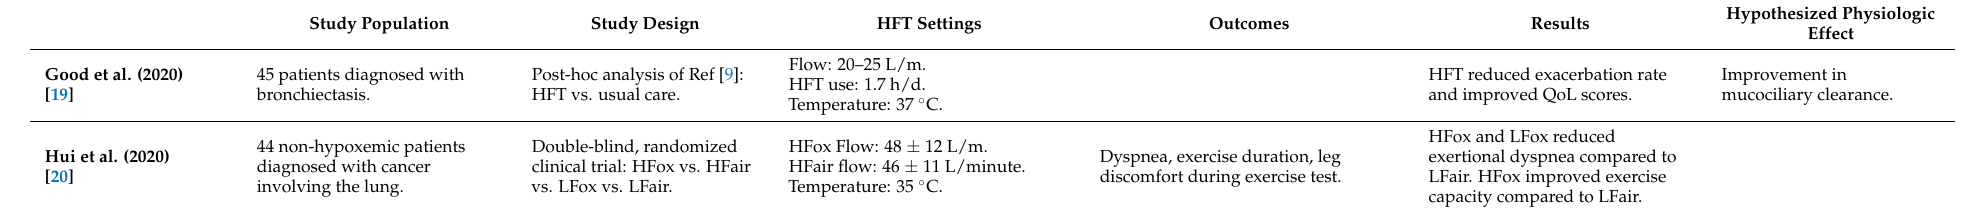
Dyspnea, exercise duration, leg discomfort during exercise test.